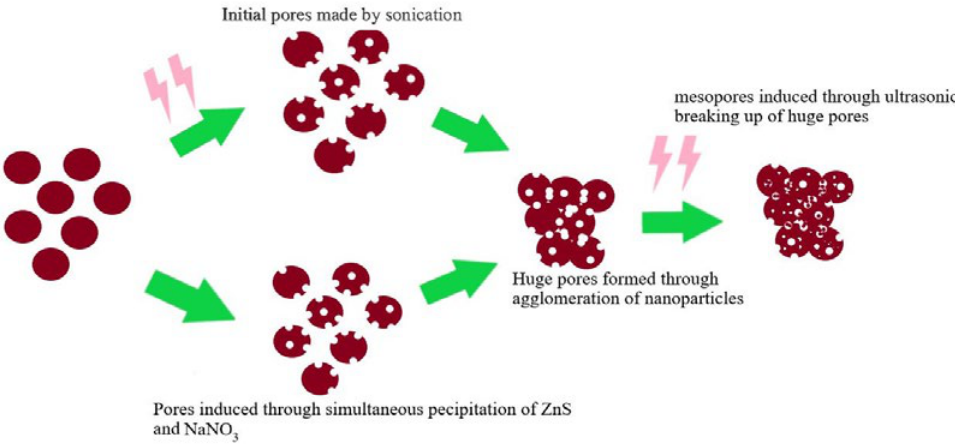
Fig. 3. Role of sonication in forming of mesoporous Figure 3 . Role of sonication in forming of mesoporous structures